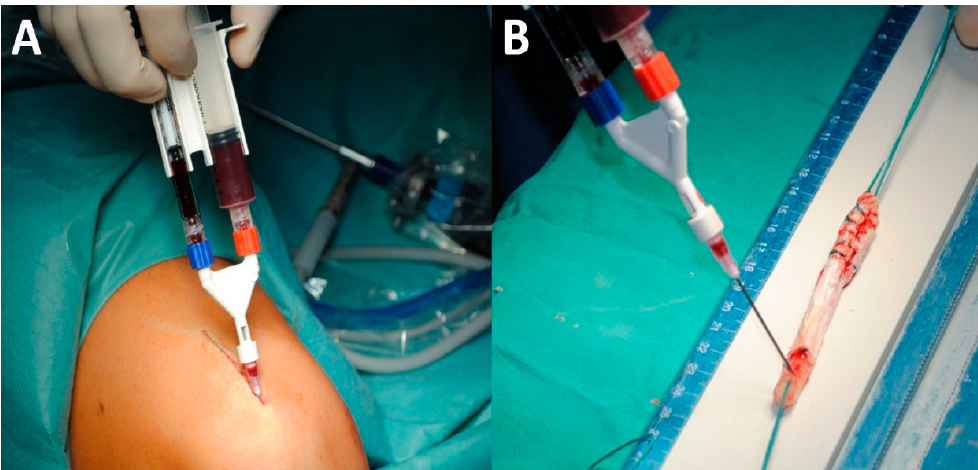
Figure 2. Administration of the PRP onto the harvest site and intra-tunnel portions of the graft: ( A ) administration of the PRP onto the harvest site of the QTB full thickness autograft; ( B ) administration of the PRP onto the intra-tunnel portions of the QTB full thickness autograft. PRP, platelet-rich plasma; QTB, quadriceps tendon bone.